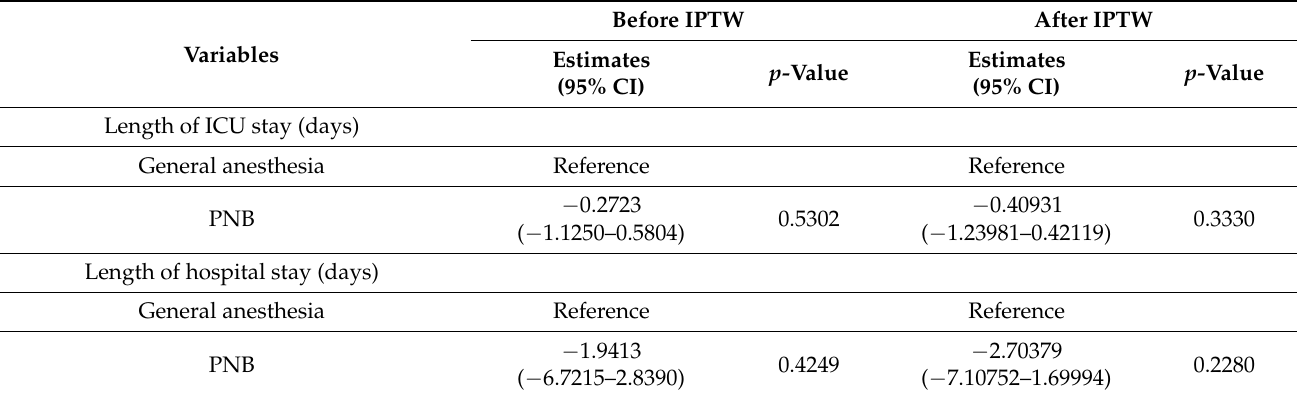
Table 4. Weighted linear regression analysis of the length of intensive care unit and hospital